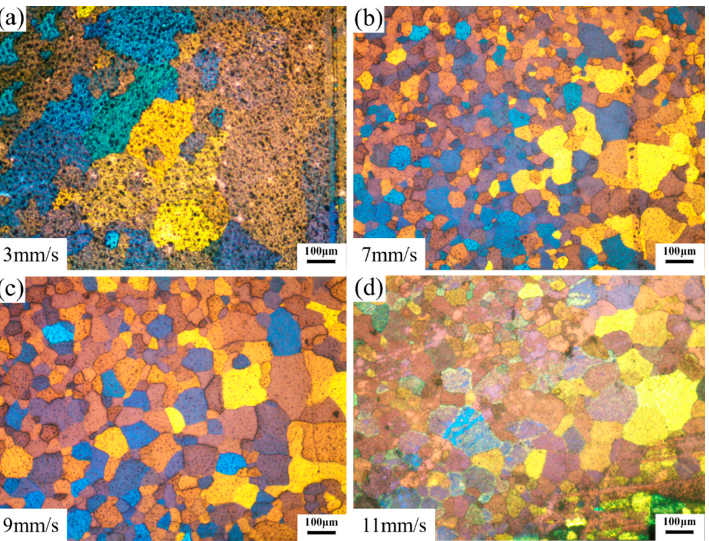
Figure 9. Microstructures of the matrix zones on the transverse cross-section. ( a – d ) different ram speed.